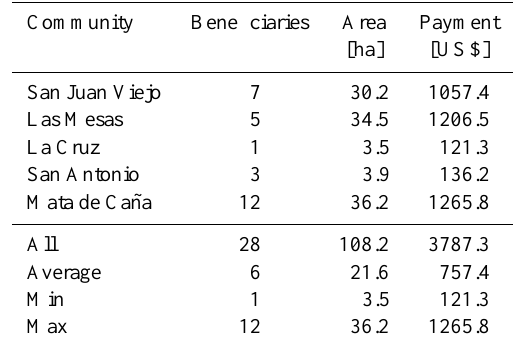
Table 2. Payment beneficiaries, respective area and total annual payment